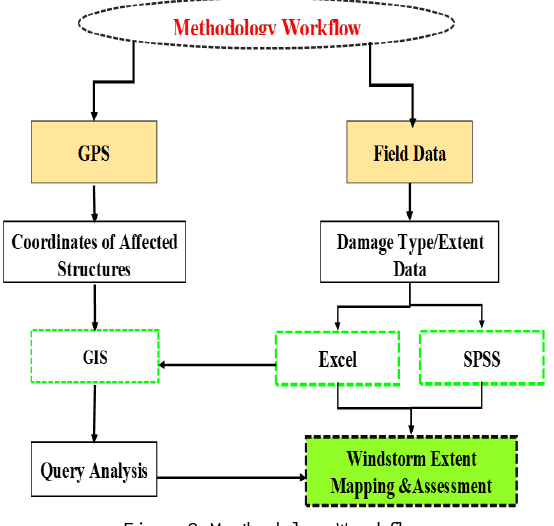
Figure 2. Methodology Workflow